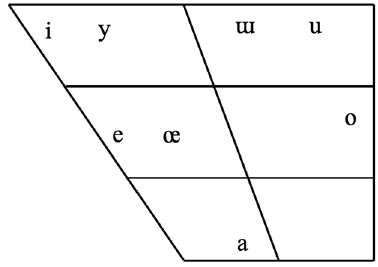
Figure 1. American English vowels in Northern Cities dialect regions according to Hillenbrand (2003).